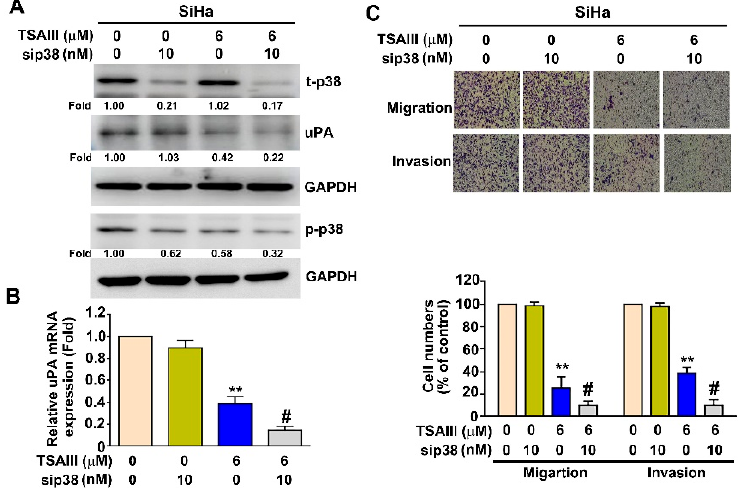
Figure 6. Cotreatment inhibitory effect of TSAIII and p38 siRNA on uPA expression, migration and invasion in human cervical cancer cells. ( A ) Human SiHa cervical cancer cells were treated with various concentrations of TSAIII (0 and 6 µ M) and/or p38 siRNA (0 and 10 nM), and then were harvested for the detection of the expression of t-p38 (total-p38), p-p38 (phosphoryled-p38) and uPA via immunoblotting assay. ( B ) The mRNA level of uPA was determined with RT-qPCR assay. ( C ) The capacity of migration and invasion of human SiHa cervical cancer cells was analyzed after TSAIII treatment in the presence or absence of p38 siRNA (10 nM) for 24 h. ** p < 0.01 versus control (line 1); # p < 0.05 versus TSAIII alone treatment (line 3) (mean ± SE, n = 3). t: total; p: phosphoryled. Uncropped WB images were shown in Figure